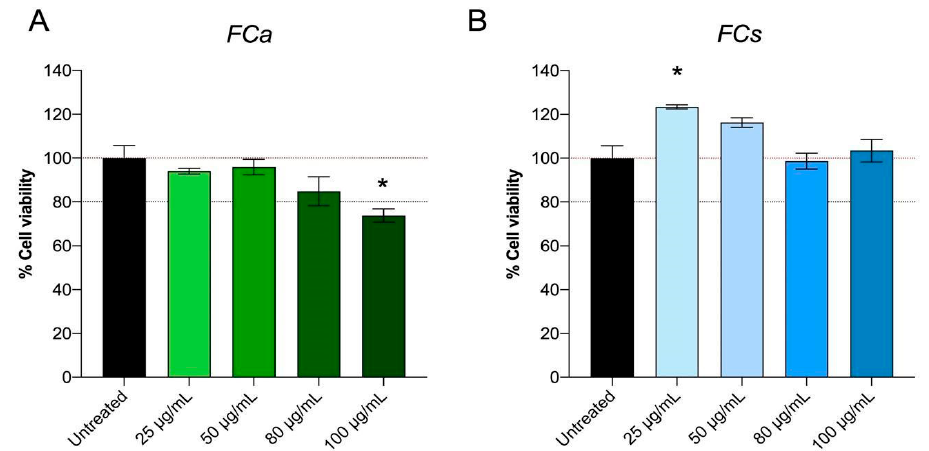
Figure 2. Effect of Ficus carica phytoextract collected (A) in autumn (FCa) and (B) in spring (FCs) on 3T3-L1 cell viability evaluated with MTT test. Data are shown as mean ± SEM; * p < 0.05 vs. control group (untreated).